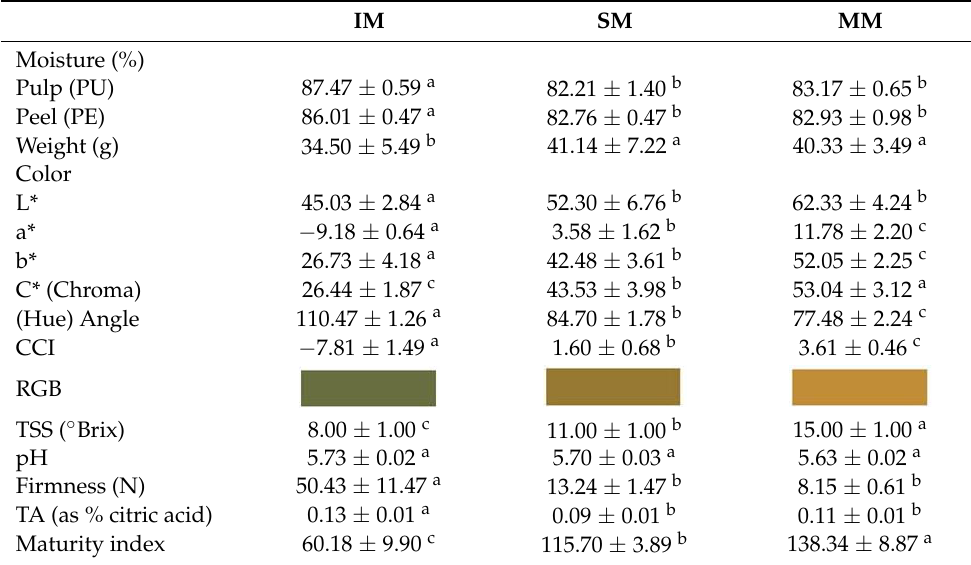
Table 1. Physicochemical parameters of ciricote fruit at three stages of maturity.